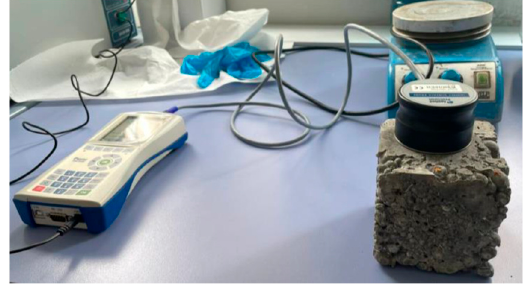
Figure 4. Experimental setup of the thermal conductivity test.